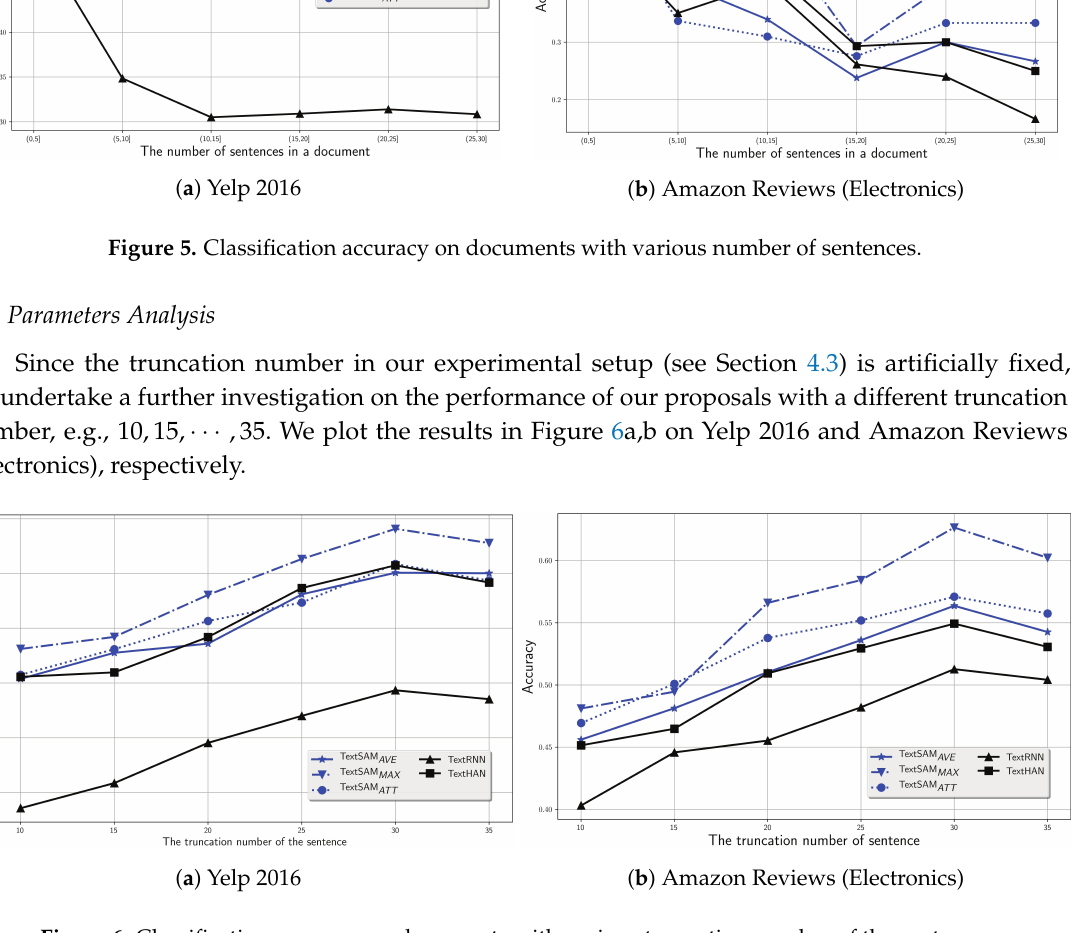
Figure 6. Classification accuracy on documents with various truncation number of the